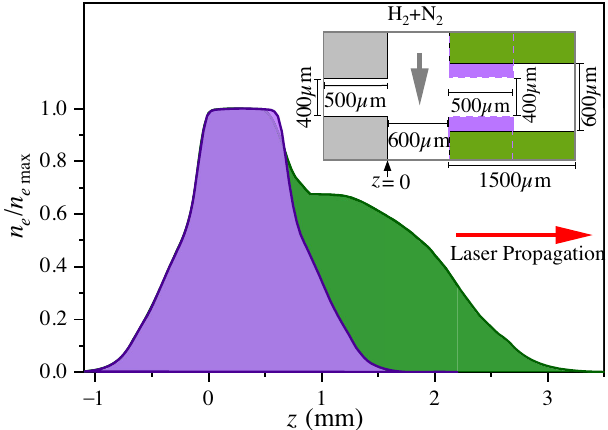
FIG. 4. Normalized electron density profile along laser axis in the gas cell from fluid simulations. Short and long exit configu- rations are indicated by purple and green plasma densities and inset dimensions, respectively. The laser travels from negative to positive z values as marked by the red